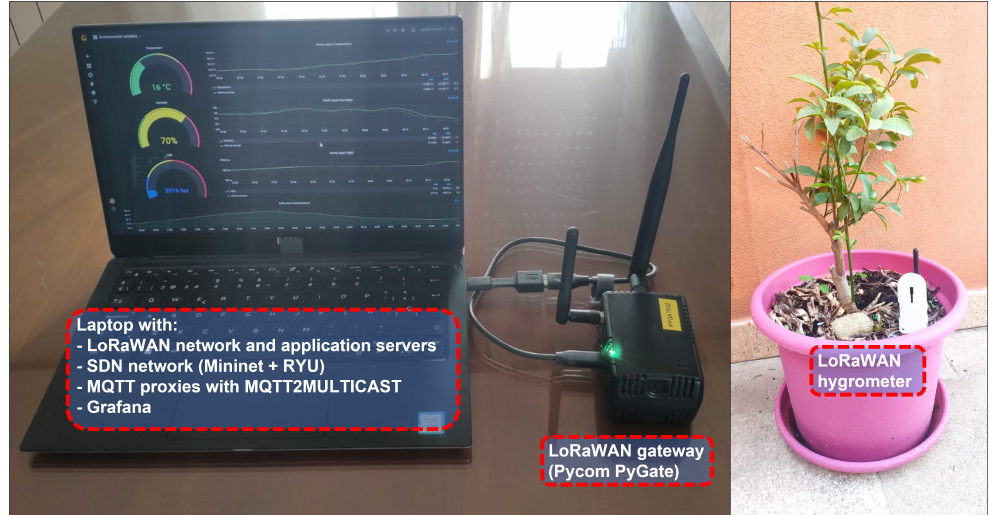
Figure 9. Proof of concept